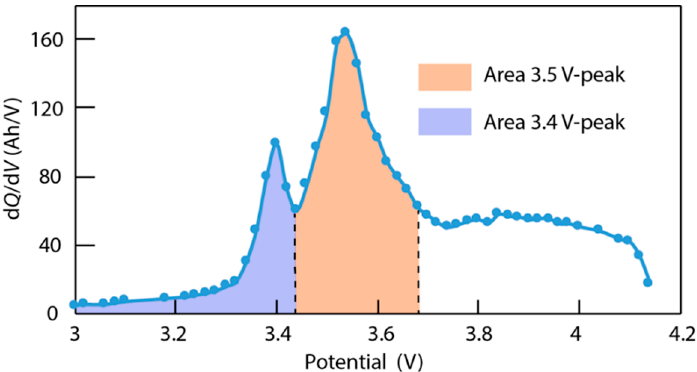
Figure 5. Incremental capacity analysis (ICA) versus voltage for one cell at the initial state, obtained for dV = 20 mV. AP-3.5 V is the area of the peak at 3.5 V and AP-3.4 V is the area of the peak at 3.4 V. Table 3. Average value of voltage and standard deviation for 3.5 V and 3.4 V peak maxima. Average Voltage of the